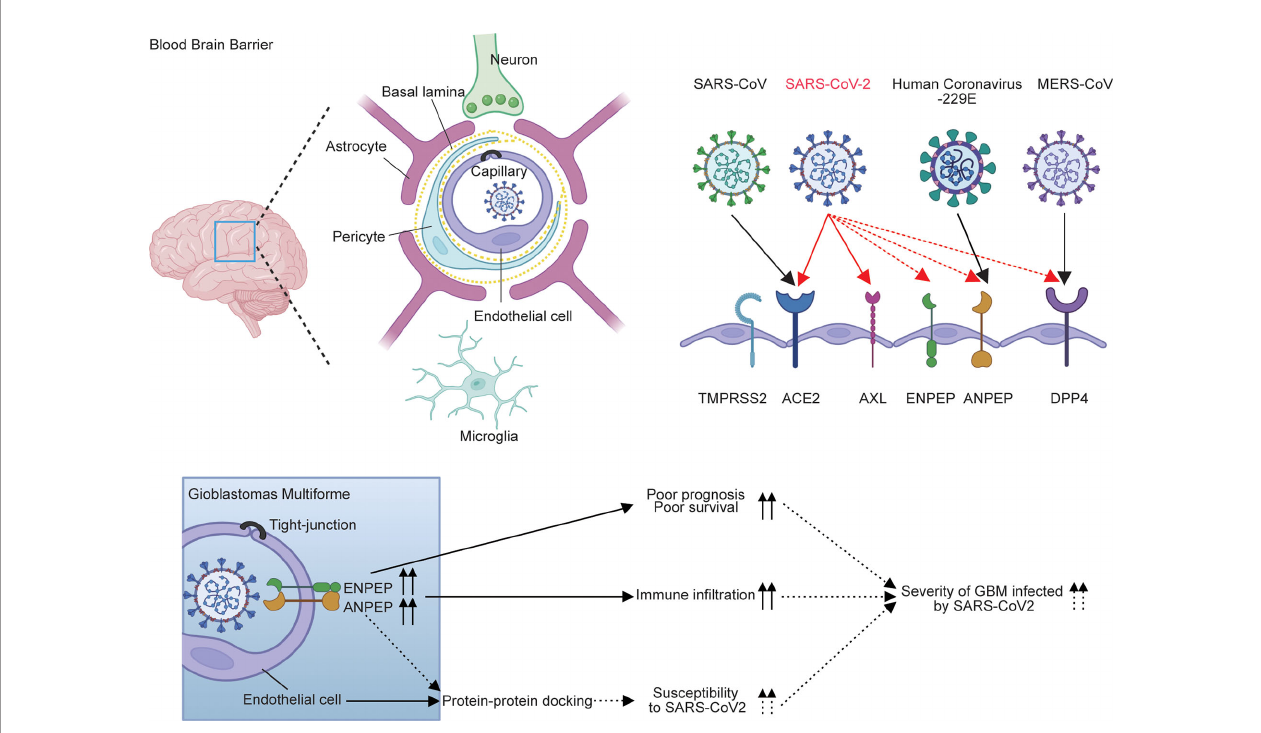
FIGURE 7 | Model for the regulation of ANPEP and ENPEP in GBM against coronavirus infections. Previous studies describe ACE2 and TMPRSS2 as the receptor or co-receptor for SARS-CoV and SARS-CoV-2; AXL for SARS-CoV-2; DPP4 for MERS-CoV; ANPEP for human coronavirus-229E; and DPP4, ENPEP and AENPEP as the candidate receptor for SARS-CoV-2. ANPEP and ENPEP are distributed in endothelial cells of the blood – brain barrier, through which coronaviruses enter the CNS. Protein-protein docking analysis of ANPEP or ENPEP to RBD of SARS-CoV-2 combined with the upregulations of ANPEP and ENPEP in GBM may cause the increase of susceptibility of GBM to SARS-CoV-2. The high levels of ANPEP and ENPEP in GBM is associated with poor survival and high immune in fi ltration. The overlap of increased risk of GBM to SARS-CoV-2, poor survival, and high immune in fi ltration may result in the severity of patients with GBM infected by